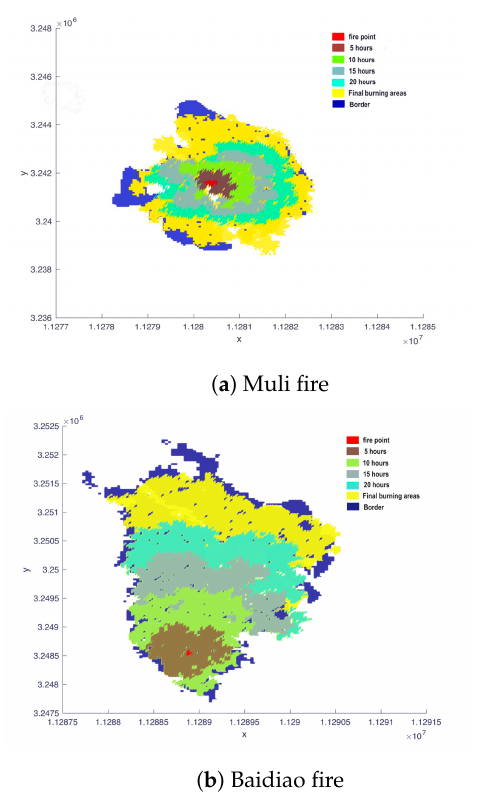
Figure 8. The simulated processes of the Muli and Baidiao fires.